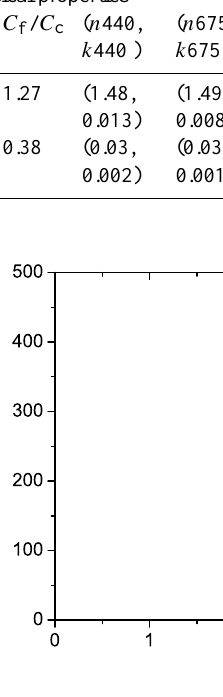
Fig. 12. Daily average BC mass concentration obtained from remote sensing retrievals (CE318) and in situ aethalometer measurements (AE51) during February 2012 in Beijing.